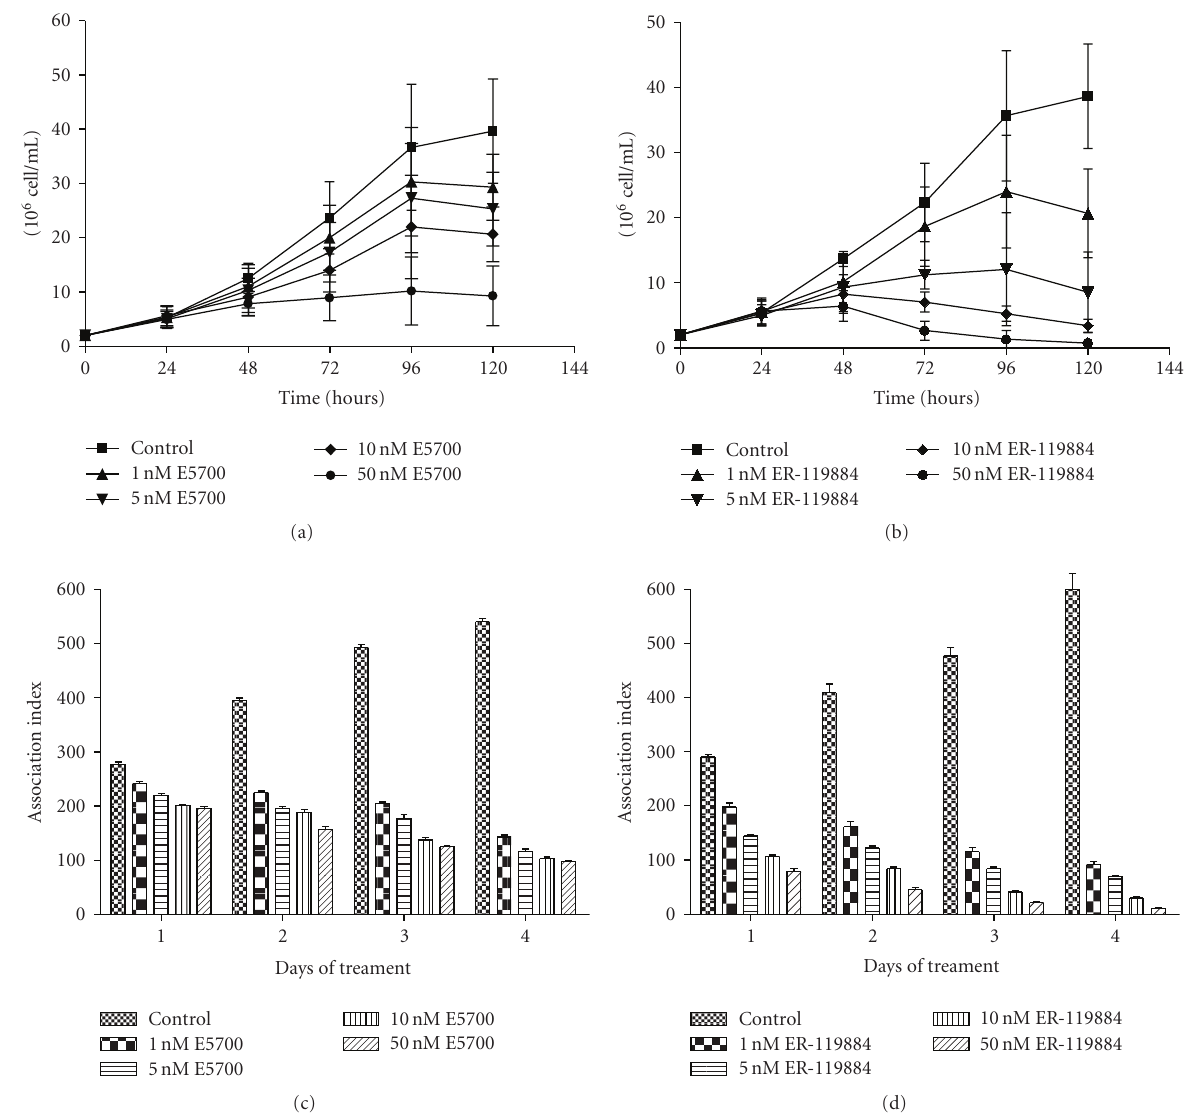
Figure 4: (a)-(b) Growth curves of promastigotes and (c)-(d) intracellular amastigotes of Leishmania amazonensis treated with two potent squalene synthase inhibitors, E5700 and ER-119884. The graphics are reproduced with permission from [37] American Society for